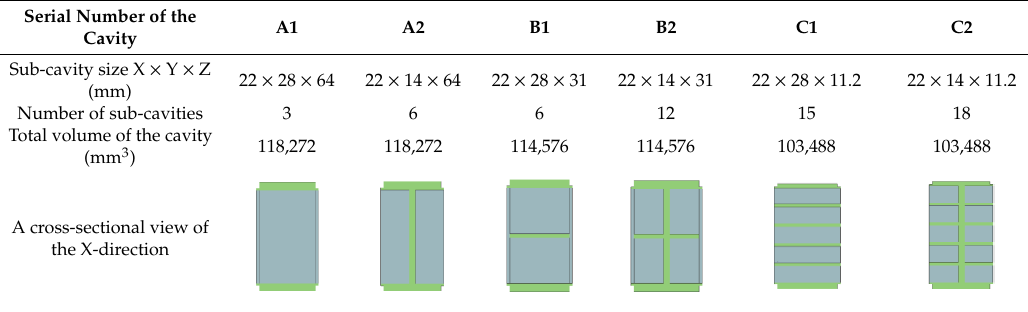
Figure 4. Schematic of experimental apparatus.